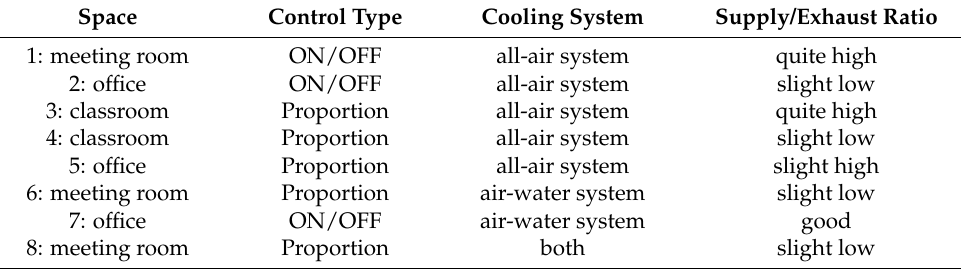
Table 11. Comparison of eight DCV